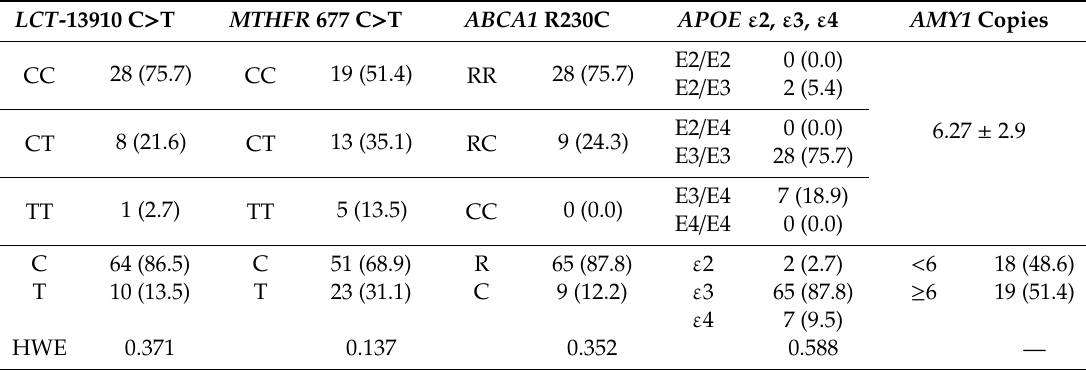
Table 2. Genetic profile of DRAG polymorphisms in 37 study